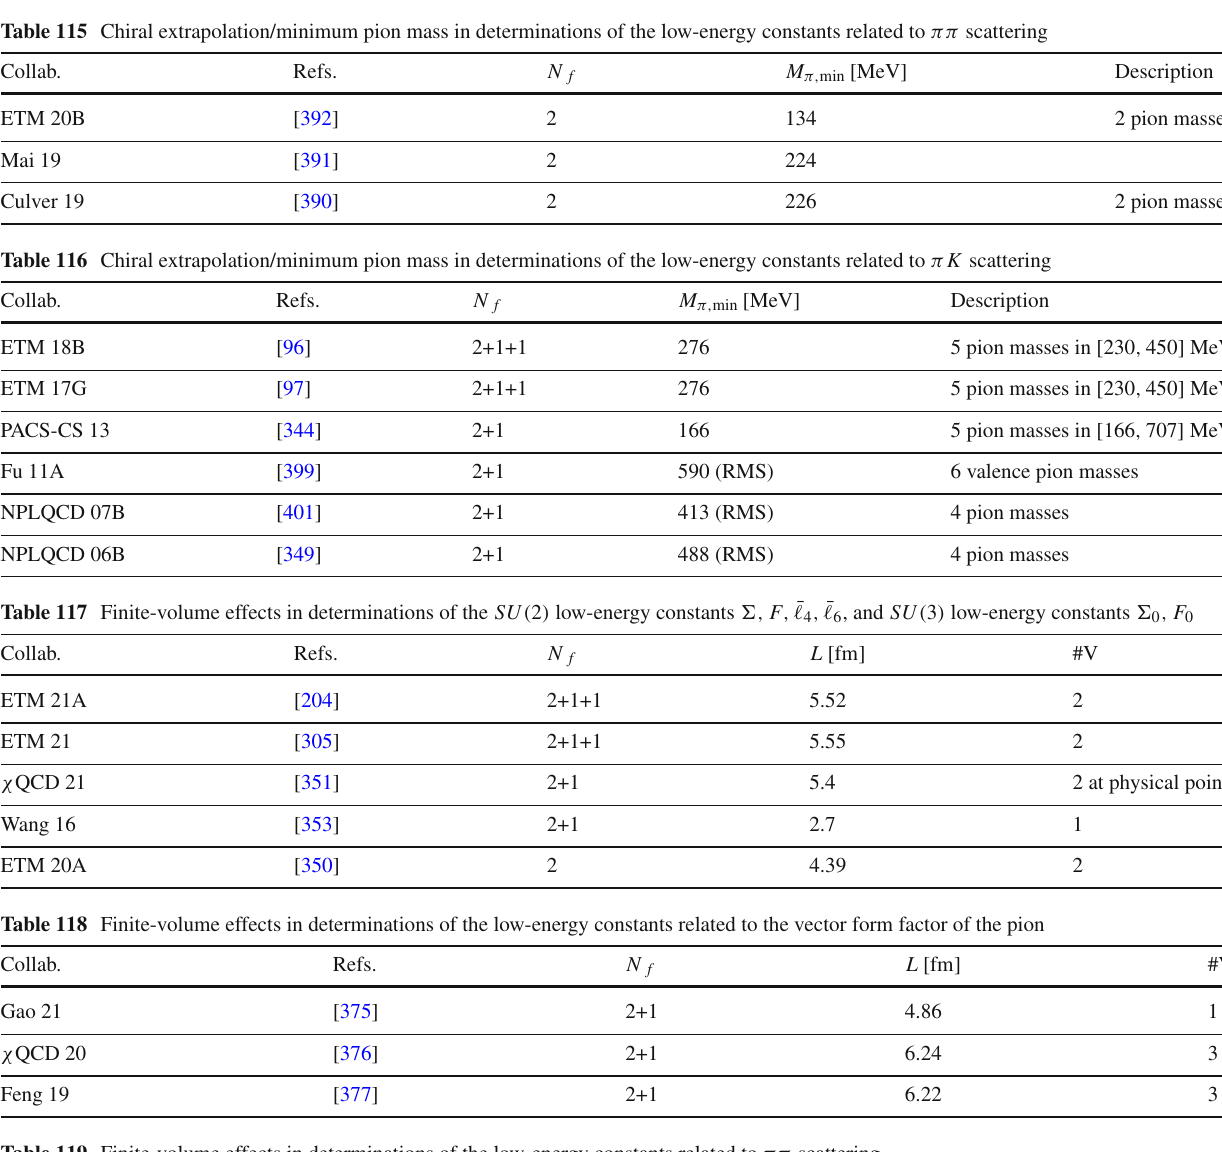
Table 119 Finite-volume effects in determinations of the low-energy constants related to ππ scattering